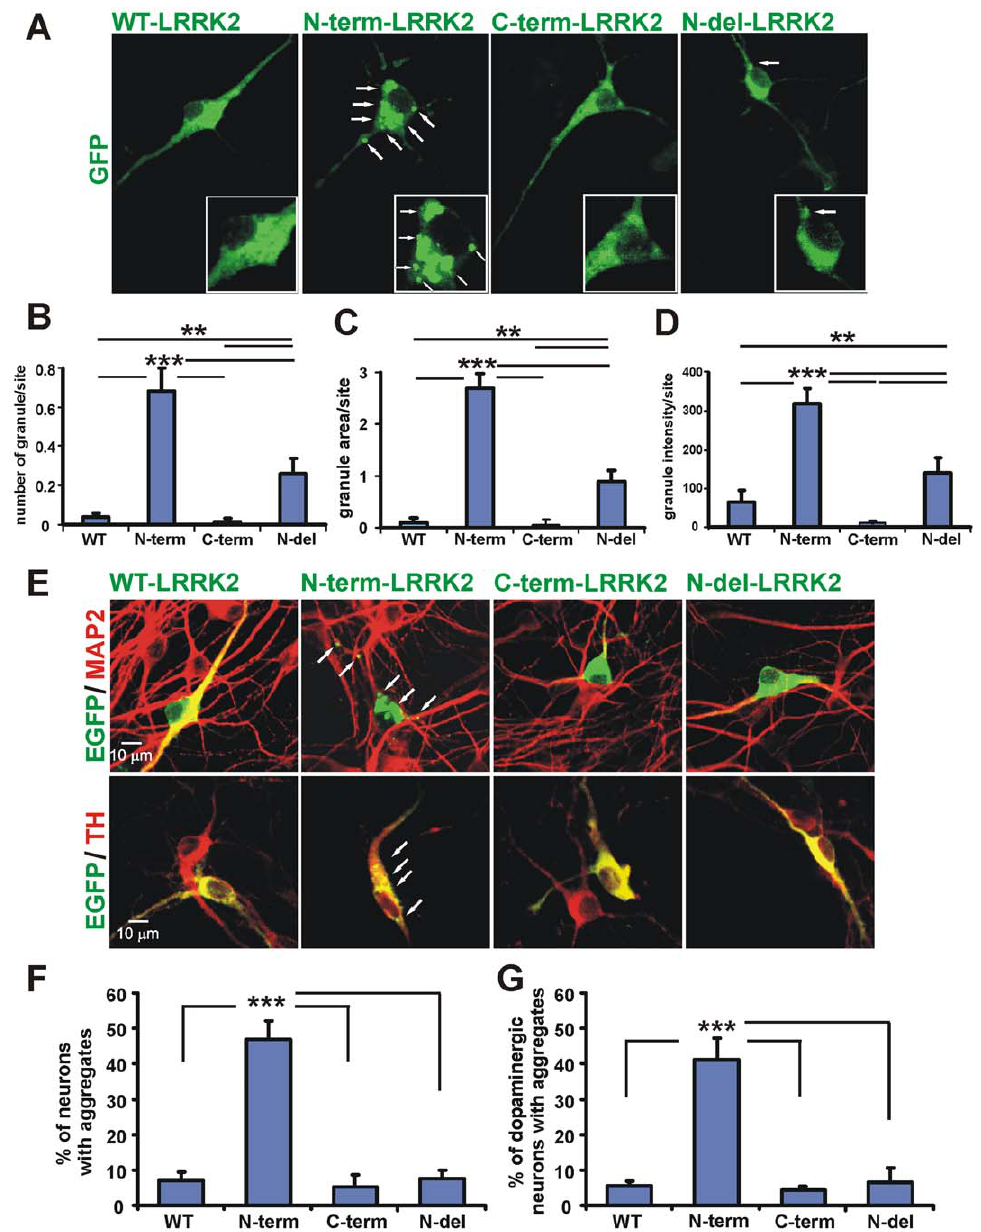
Figure 5. Increased N-term-LRRK2 aggregation in mesencephalic neurons. ( A ) Representative images showing N-term-LRRK2 cells with increased high intensity aggregates (arrows) in the cell body and neurites compared to WT-, C-term-, or N-del-LRRK2 constructs. Inset of the cell body is enlarged (bottom) to illustrate aggregates (arrows). Aggregates were quantitated utilizing number of granules/site ( B ), total granule area/site ( C ), and average granule intensity per site ( D ). Data shown are average of 3 independent experiments with more than 6 dishes/construct and 64 images/ dish. (** P , 0.01, ***P , 0.001, one-way ANOVA with Bonferroni post hoc test). ( E ) Representative images showing the colocalization of EGFP-LRRK2 with MAP2 or TH immunostaining. Increased aggregates were observed in N-term-LRRK2 neurons including dopaminergic neurons. ( F ) Quantitation of numbers of LRRK2/MAP2 positive neurons with aggregates. Bars represent means of three experiments 6 S.E.M. with multiple dishes and a total of about 600 MAP2 positive neurons analyzed. (*** P , 0.001, one-way ANOVA with Bonferroni post hoc test). ( G ) Quantitation of numbers of LRRK2/TH- positives neurons with aggregates. Bars represent mean values from each of 4 experiments 6 S.E.M. A total of about 150 dopaminergic neurons were analyzed (*** P , 0.001, one-way ANOVA with Bonferroni post hoc